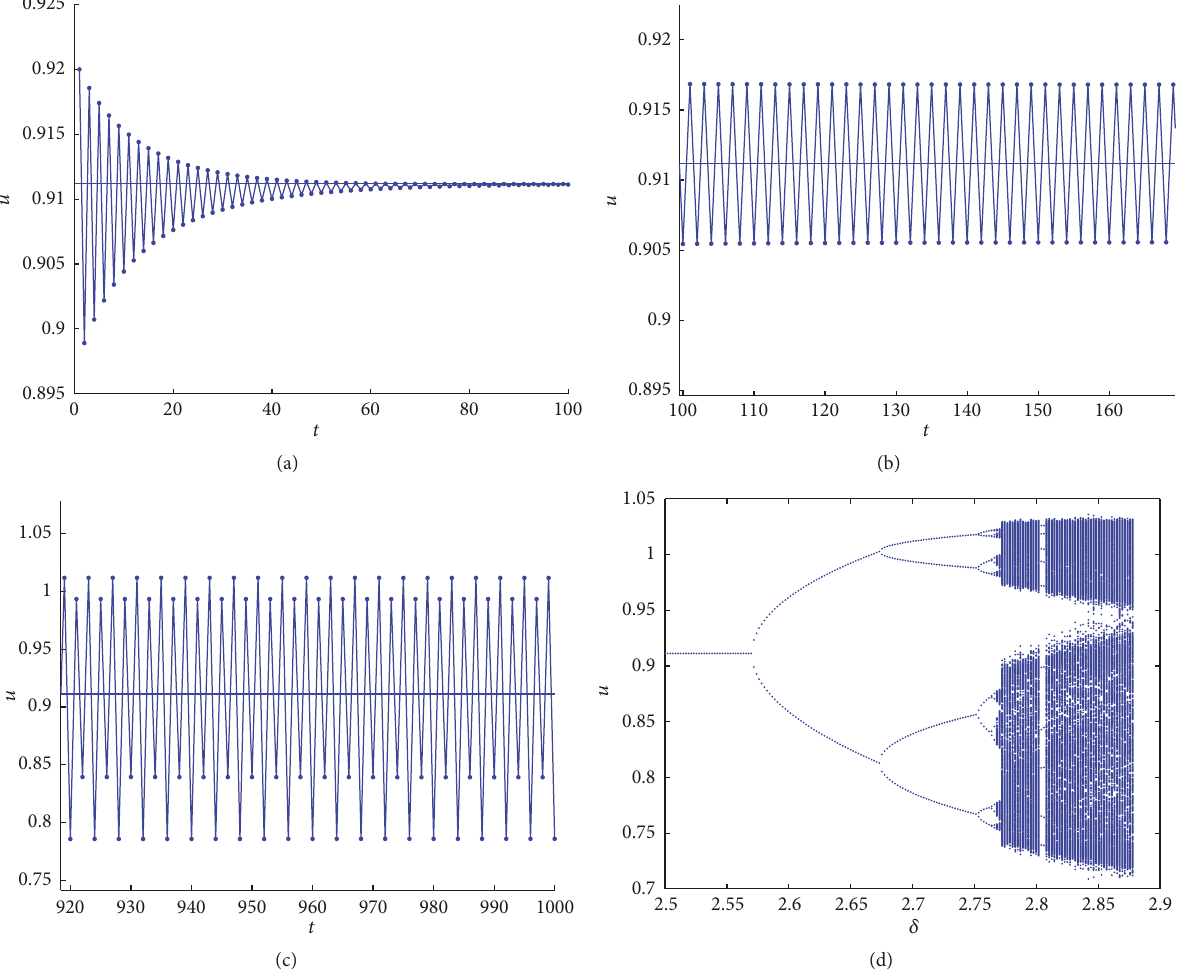
Figure 2: The initial value is (0.92, 0.1) , (a) 𝛿 = 2.56 , the middle line 𝑢 = 0.9112 denotes the equilibrium point and the equilibrium point is stable, (b) 𝛿 = 2.5705 , there is a period-2 orbit, (c) 𝛿 = 2.7 , there is a period-4 orbit, and (d) the bifurcation diagram in (𝛿 - 𝑢) plane, showing the process of period doubling and